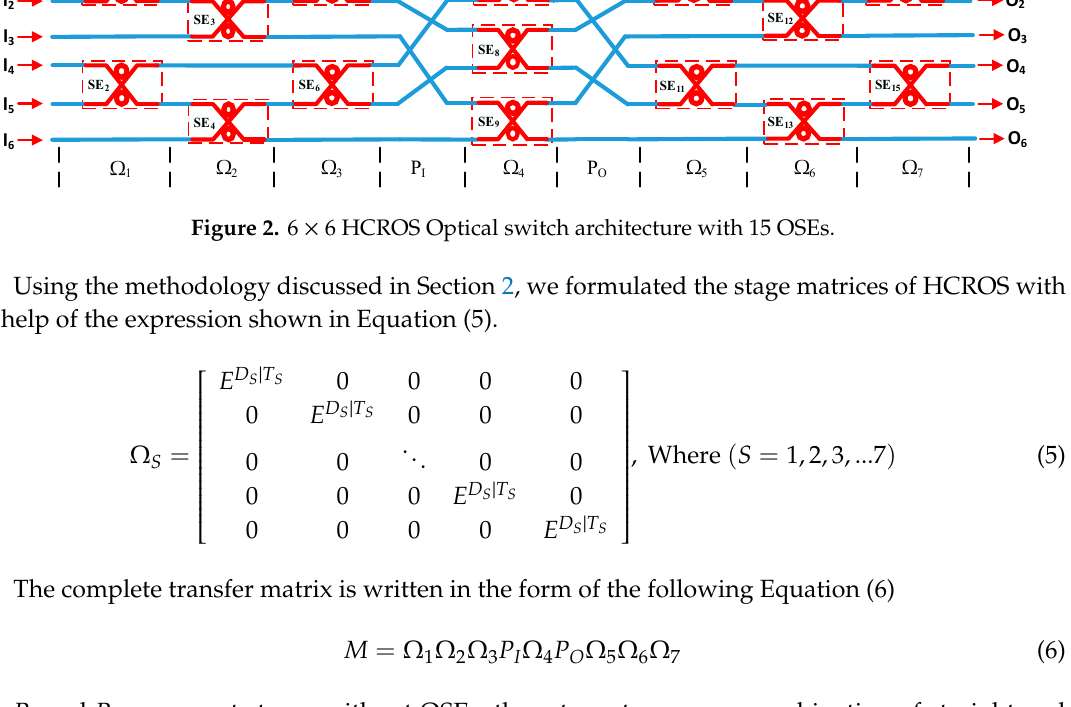
Table 2. Routing combinations for the 6-port optical switch.